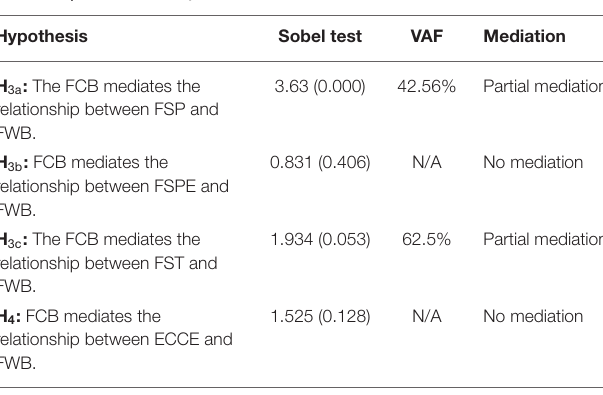
TABLE 6 | Mediation